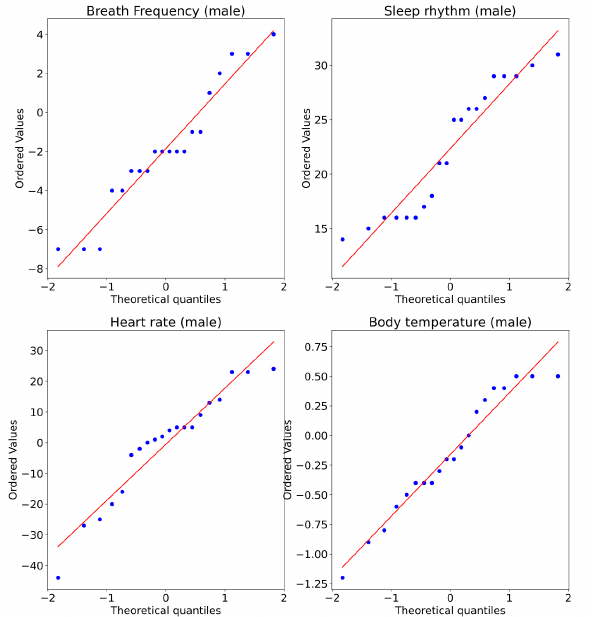
Figure 15. Q–Q plot of measurements captured for two conditions, without and with sensors, for male subjects.